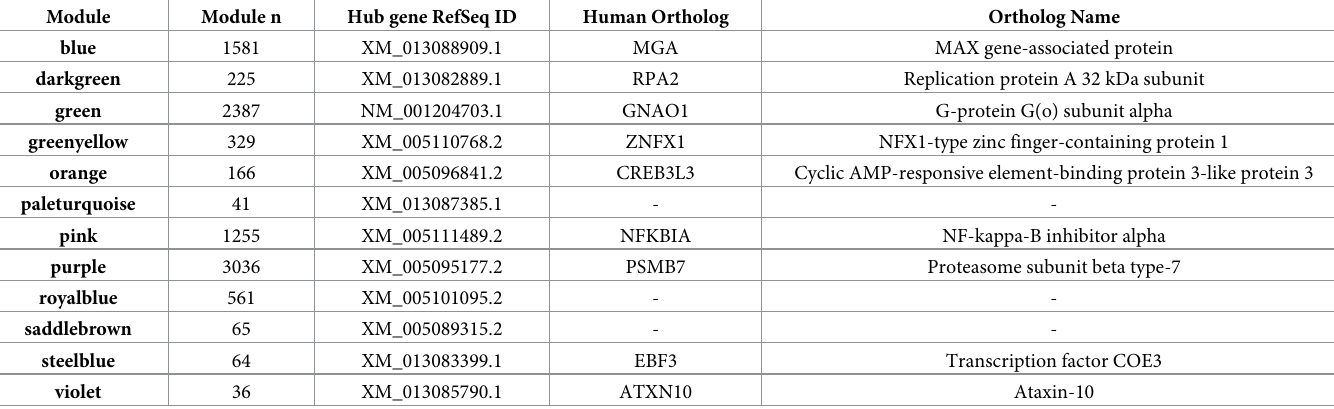
Table 1. Co-expression modules identified in Aplysia californica sensory neurons.